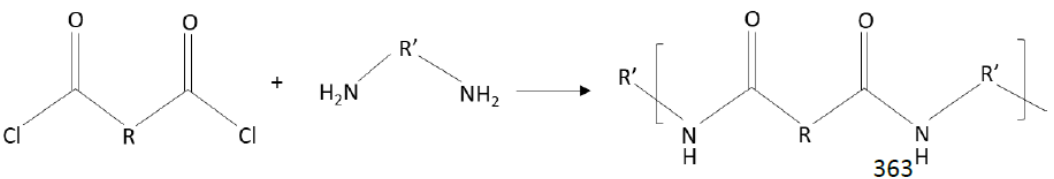
Figure 5. Polyamide formation via reaction between a two-acyl chloride monomer and a two-amine group monomer (after [135]).